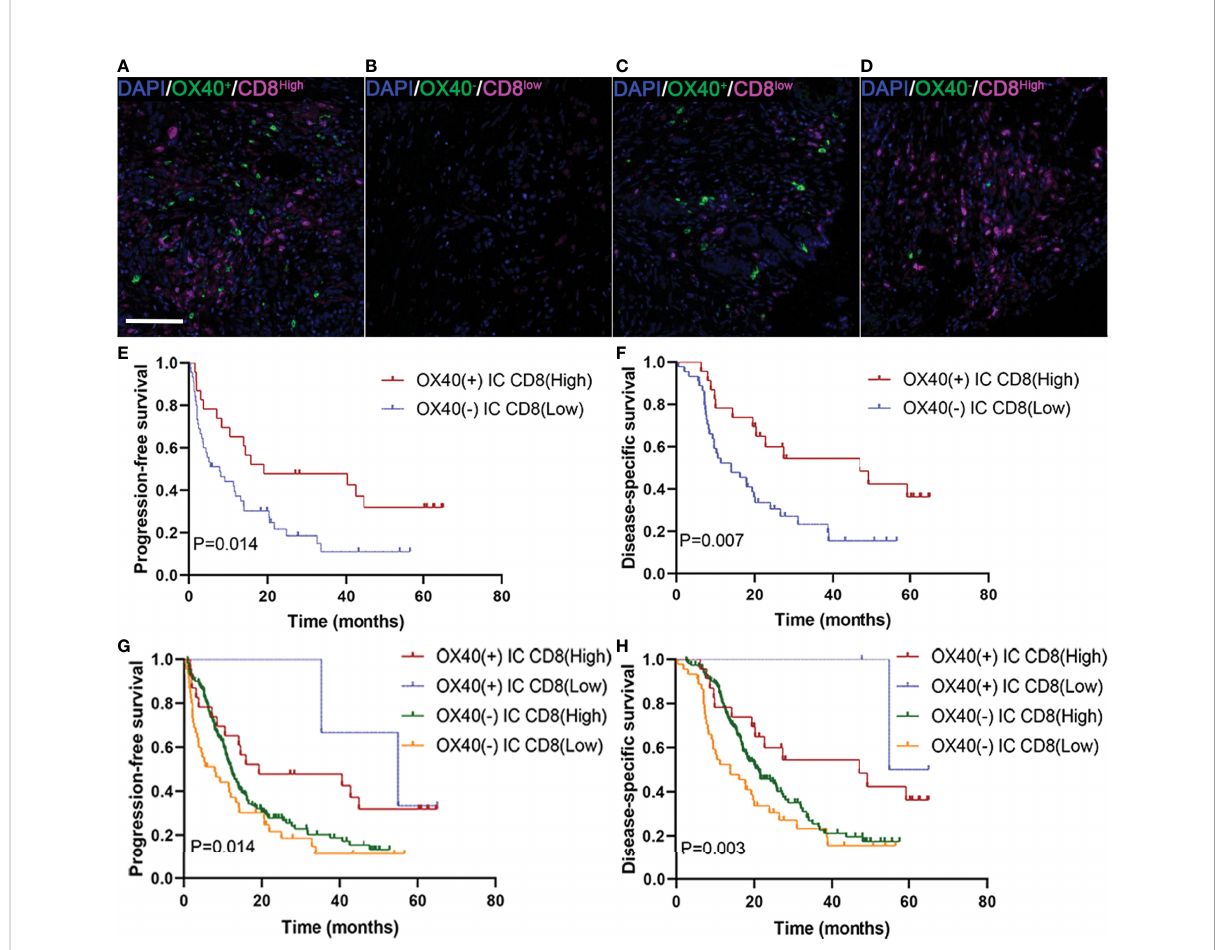
FIGURE 5 Localization of OX40 on immune cells (ICs) and CD8+ T cells and their correlations with prognosis in pancreatic ductal adenocarcinoma (PDAC). (A) OX40+ on ICs/CD8+ T cells high , (B) OX40+ on ICs/CD8+ T cells low , (C) OX40+ on ICs/CD8+ T cells low , and (D) OX40+ on ICs/CD8+ T cells high . Kaplan – Meier curves of progression-free survival and disease-speci fi c survival in patients with PDAC based on the combination of OX40 on ICs and CD8+ T cells (E – H)